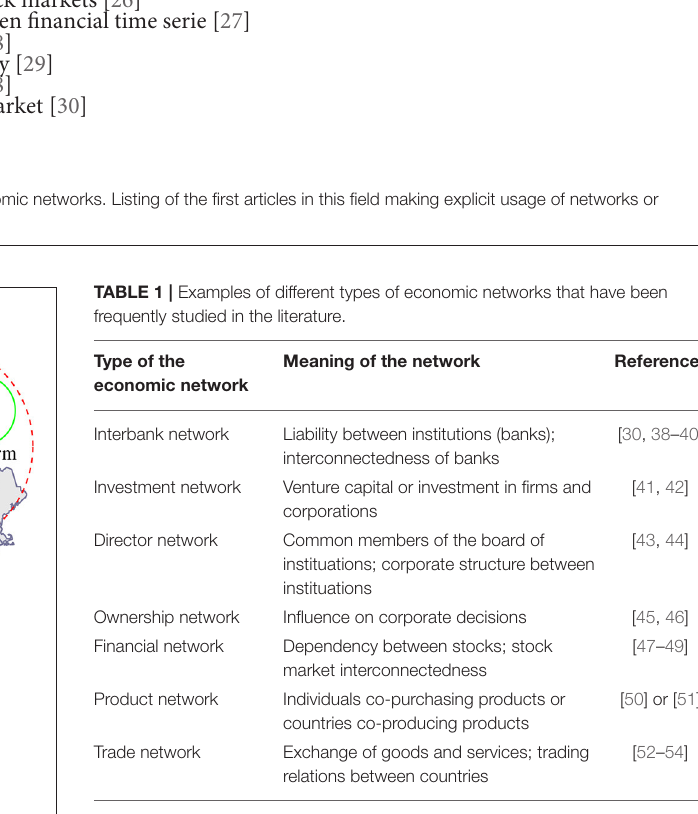
FIGURE 2 | Visualizing the meaning of “nodes” in economic networks for an abstract four-node network (top). Each node color corresponds to a state (CA, TX, WA, and NY) and each state is a collection of its cities, whereas each city is a collection of banks and firms located therein. Furthermore, each bank or firm is directed by a board of directors. Finally, banks or firms can form business groups and the collection of states form a country.